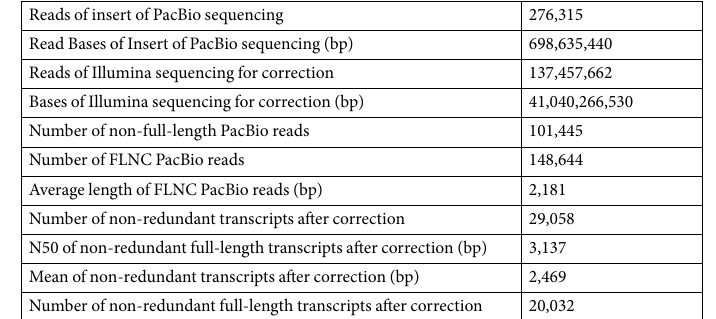
Table 1. Summary of PacBio- and Illumina RNA sequencing